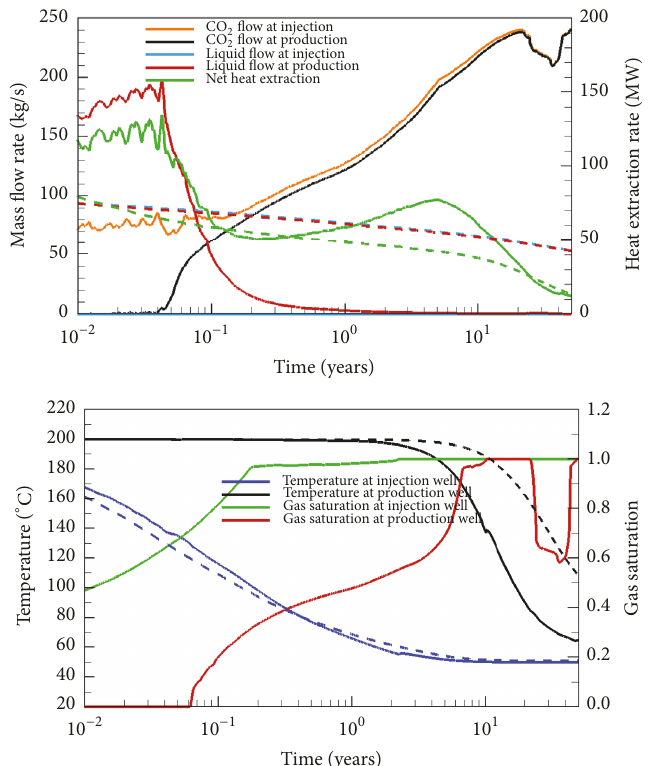
Figure 2: Simulated heat extraction rate, mass flow rate, temperature, and gas saturation next to production well for scCO 2 (solid line) and water (dash line) as working fluids,